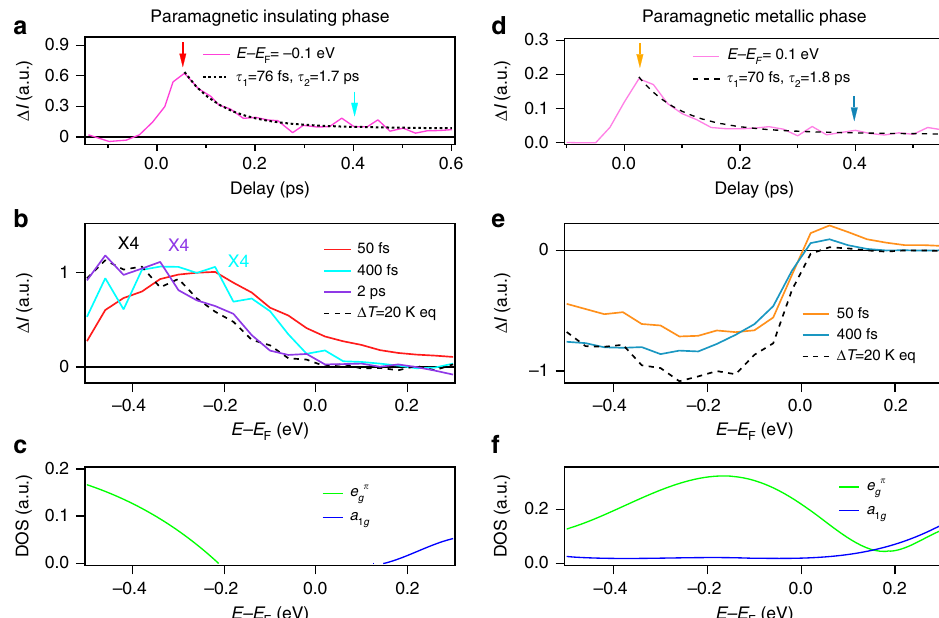
Figure 2 | trPES for (V 1 (cid:2) x Cr x ) 2 O 3 for the PI and PM phases at a fluence of 1.8mJcm (cid:2) 2 . ( a ) Time evolution of the intensity difference at (cid:2) 0.1eV, the curve is fitted with a double exponential. ( b ) PES intensity difference for D t ¼ 50fs, 400fs and 2ps are shown for the PI phase as well as the equilibrium temperature difference from Fig. 1. The 50 and 400fs differences show that the spectral weight is transferred inside the Mott gap, differently from a purely thermal effect. This non-thermal distribution relaxes within 2ps. ( c ) Orbital character of the DOS near E F extracted from ref. 22. ( d – f ) Same as ( a – c ) but for the PM phase. The time evolution is fitted with a double exponential for the energy above E F